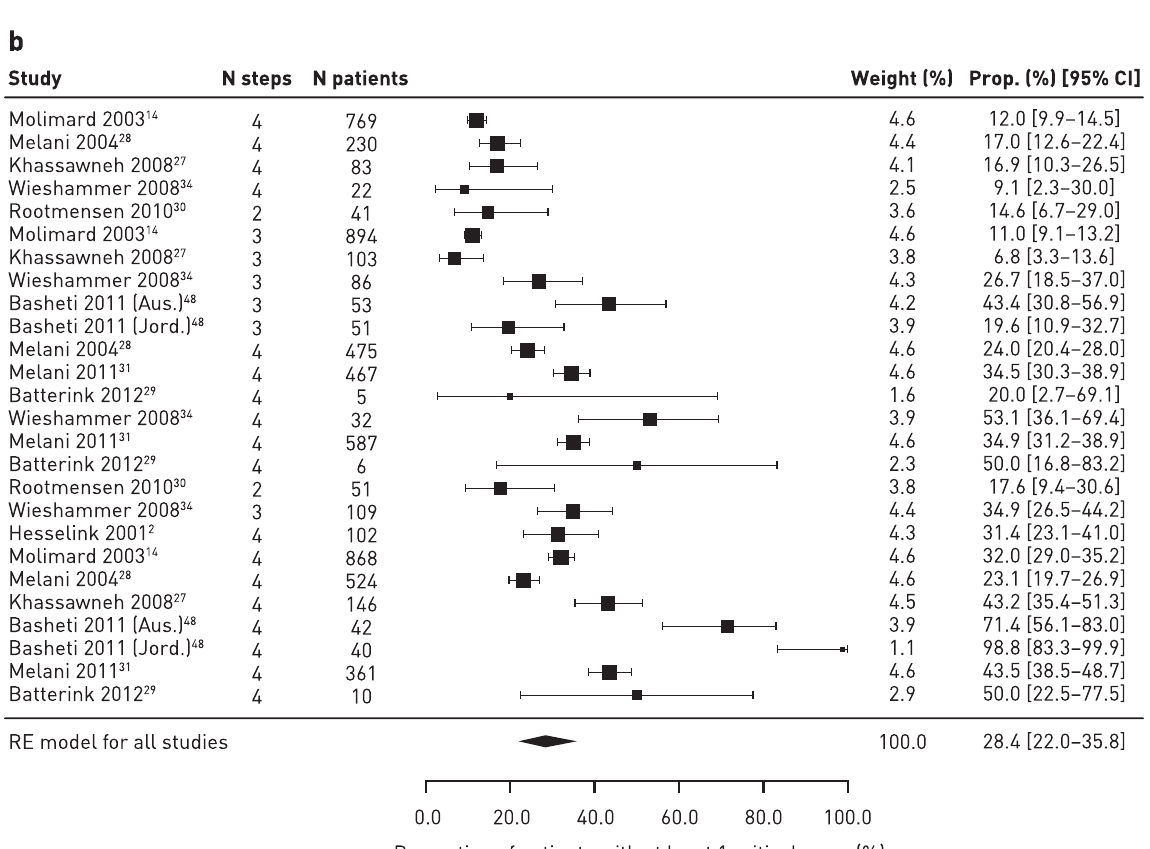
Fig. 3 Meta-analysis of the overall error rate frequency ( a ) and critical error frequency ( b ) for DPIs in prospective/cross-sectional